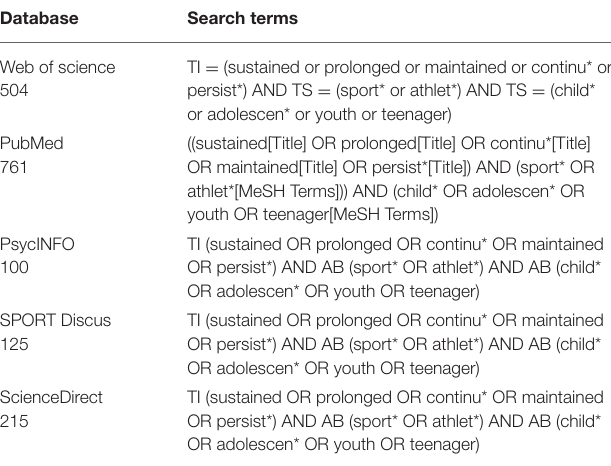
TABLE 1 | Search terms used for systematic